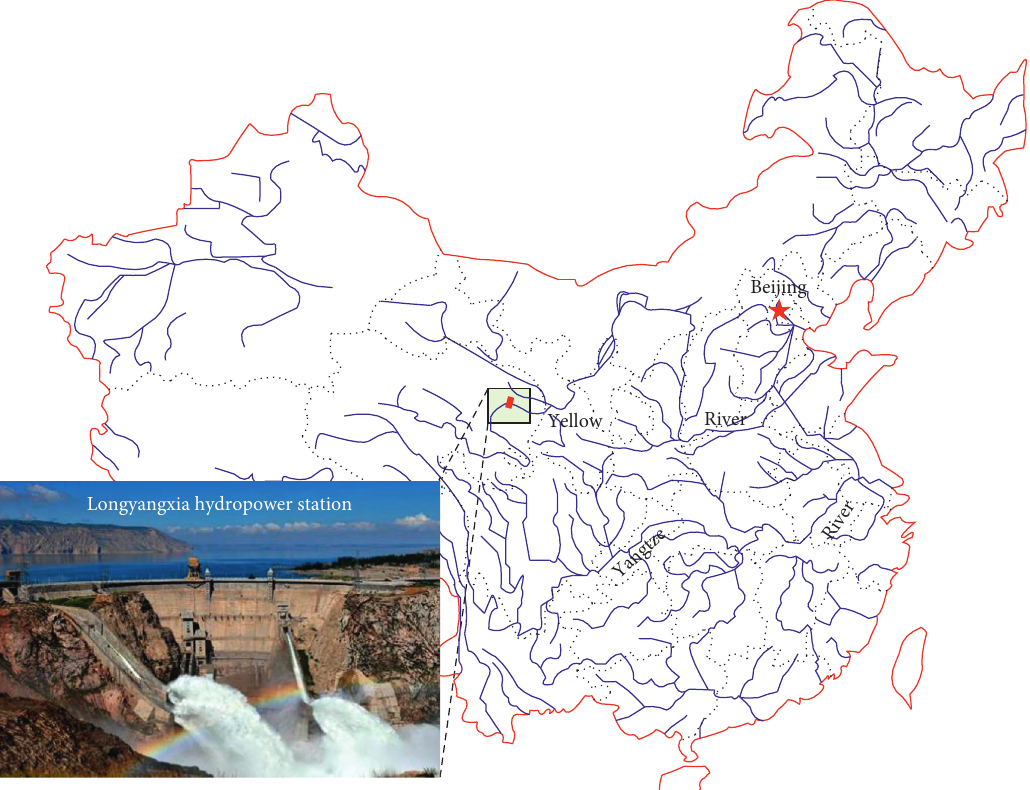
Figure 9: The Longyangxia hydropower